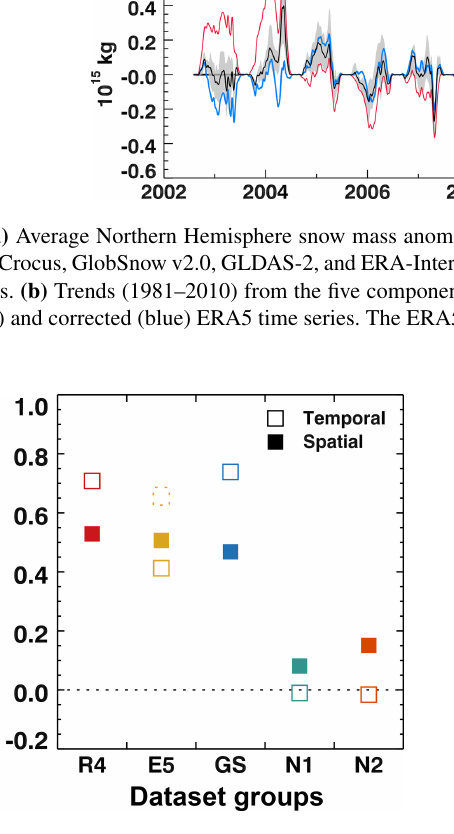
Figure 8. Temporal and spatial correlations among groups of prod- ucts over the 2002–2010 time period. Temporal correlations assess the extent to which anomalous northern hemispheric snow mass jointly evolves between pairs of datasets while spatial correlations assess the pattern correlation of SWE fields for pairs of datasets; see text (Sect. 2.3) for details. R4 is the average of six pairwise correlations between Crocus, GLDAS-2, ERA-Interim/Land, and MERRA-2. E5 is the average of four pairwise correlations between ERA5 and each R4 product. GS is the average of four pairwise cor- relations between GlobSnow v2.0 and each R4 product. N1 is the average of four pairwise correlations between AMSR-E v1.0 and each R4 product. N2 is the average of four pairwise correlations be- tween AMSR-E v2.0 and each R4 product. The dotted square shows the impact of correcting the E5 snow mass anomalies for a discon- tinuity introduced in